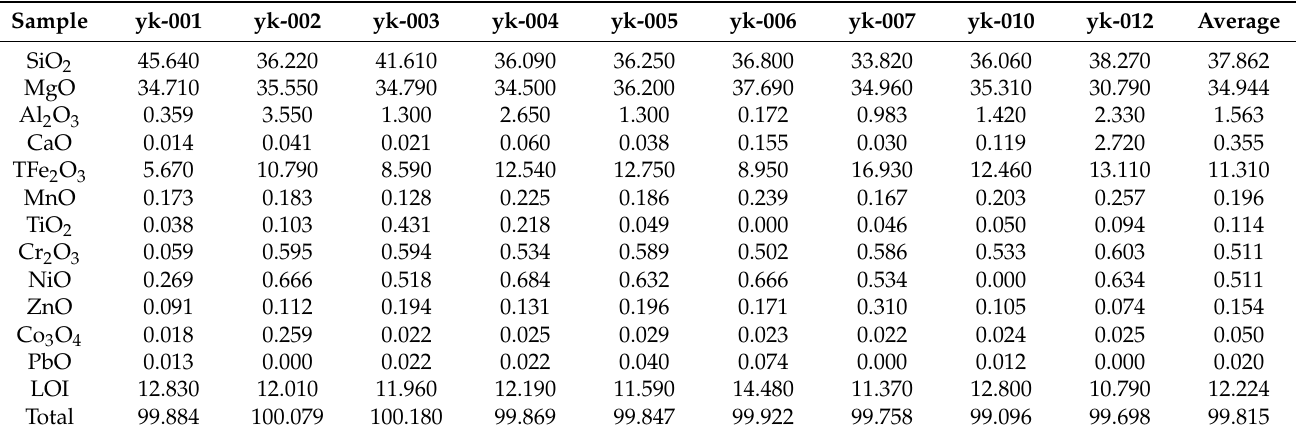
Table 3. Whole rock oxide contents in “Laoshan Jade”